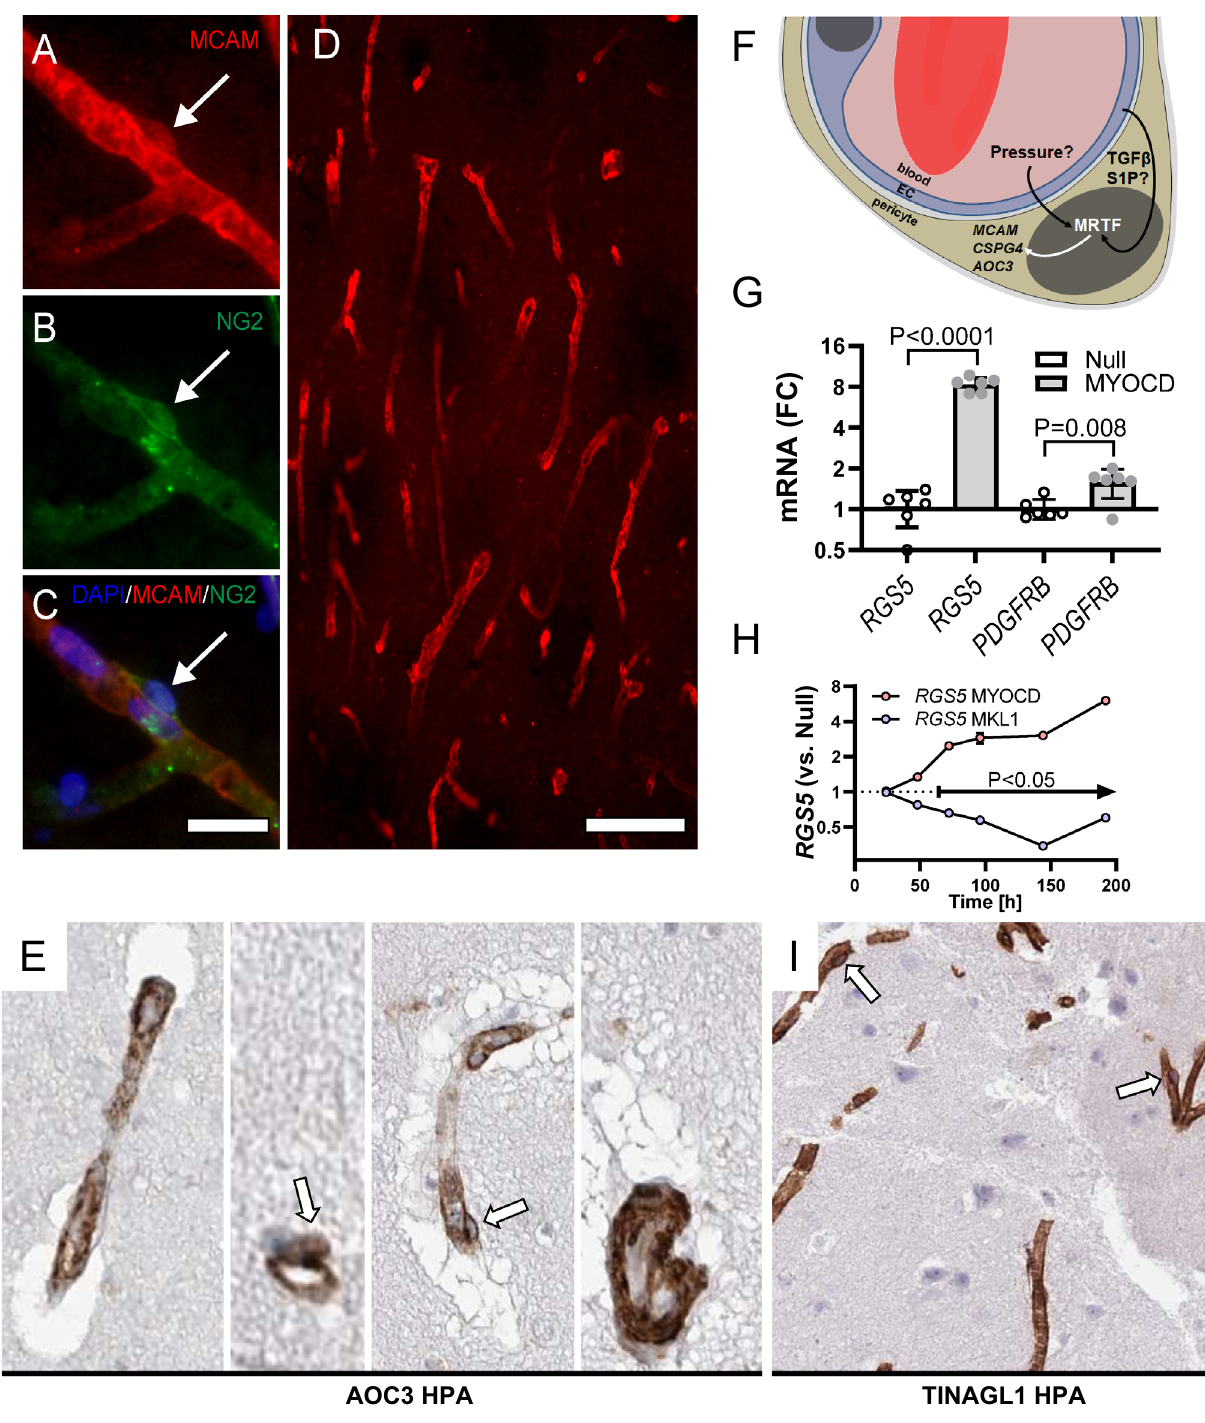
Figure 6. Co-expression of CD146/ MCAM , NG2/ CSPG4 , and VAP1/ AOC3 in endothelial cells and pericytes in the human brain. Human brain specimen stained with antibodies versus MCAM ( A ) and CSPG4 ( B ) showed co-expression in pericytes and endothelial cells (overlay in C ). MCAM expression in the human brain was restricted to vascular structures ( D ). Panel ( E ) shows four examples of immunohistochemical staining for AOC3 (brown) in the human brain from the Human Protein Atlas (HPA) 49 . Endothelial cells and pericytes (arrows) in capillaries and larger vessels were positive. Panel ( F ) shows a tentative model for regulation of MCAM , CSPG4 and AOC3 by MRTFs in pericytes (and endothelial cells) at the human blood–brain barrier. In the illustration, MRTF refers to the three myocardin-related transcription factors MYOCD, MRTF-A/MKL1, and MRTF-B/MKL2. Upstream activators of MRTFs were not examined herein, but some possibilities are given, such as sphingosine-1-phospate (S1P) and transforming growth factor β (TGFβ). Panel ( G ) shows RT-qPCR data for two validated markers of pericytes, RGS5 and PDGFRB (N = 6, 8 days of transduction) in control conditions and after overexpression of MYOCD. Panel ( H ) shows time-course data for the RGS5 transcript on overexpression of MYOCD and MRTF-A/MKL1, respectively (N = 4 for all times). Null data was generated for each time and used for statistical comparisons but was omitted from the graph for clarity. Panel ( I ) shows staining for TINAGL1 in human cerebral microvessels (from the